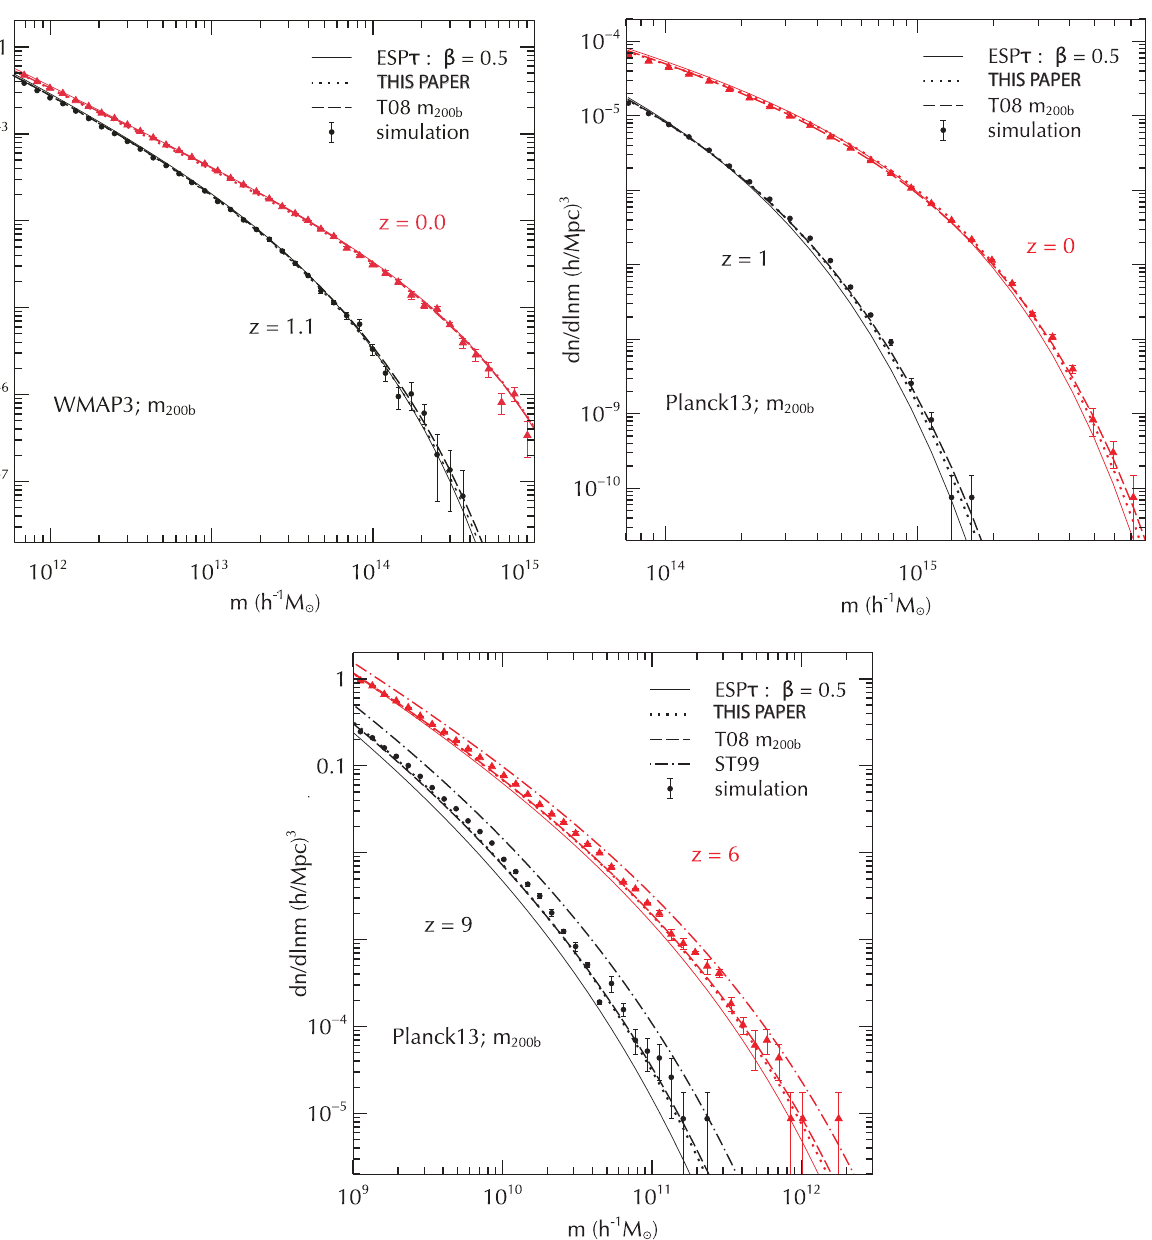
Figure 4. Comparison of the mass function of this paper with other mass functions at z = 0, and z = 1.1. The solid line represents Eq. 15 in Castorina et al. (2016) (ESP τ model), the points with errorbars the simulation in the same paper for WMAP3 (left panel) and Planck13 (right panel) cosmologies. The dashed line is T08, and the dotted line the MF of this paper. The bottom plot represents the same quantities for z = 6, and z = 9. The dot-dashed line represents the ST1 MF.